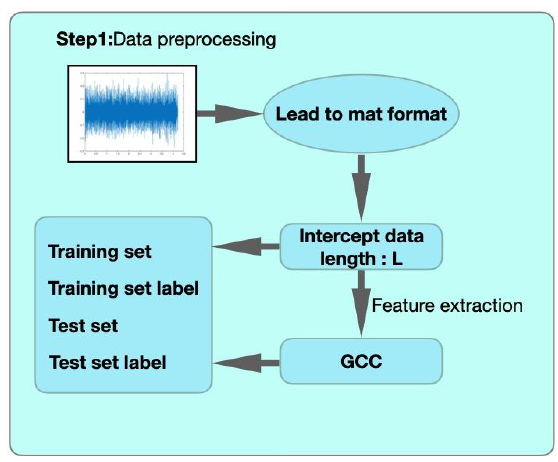
Figure 3: Data acquisition and pre-processing flowchart